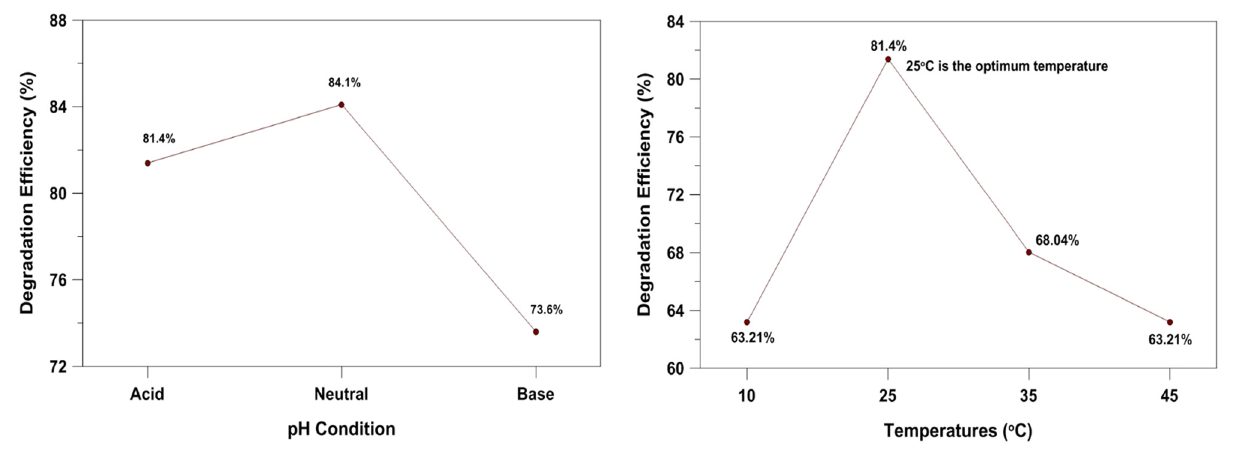
Figure 2: Determination of the optimal pH. Figure 3: Determination of